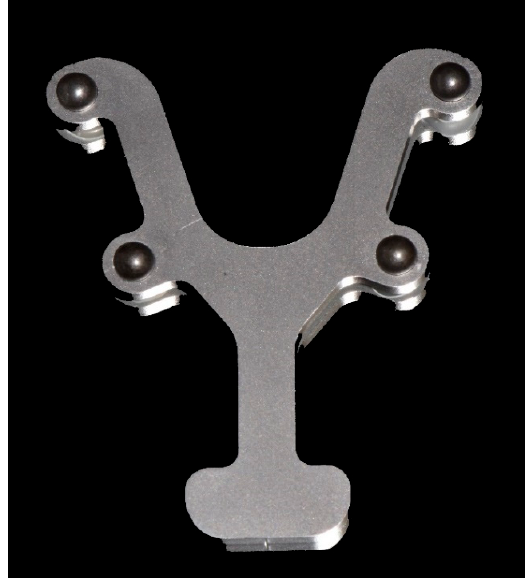
Figure 1. Metallic reference aid with four steel spheres.